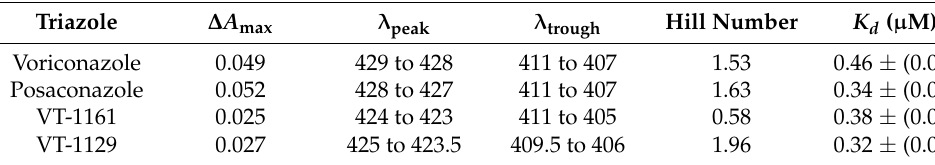
Values in brackets indicate standard